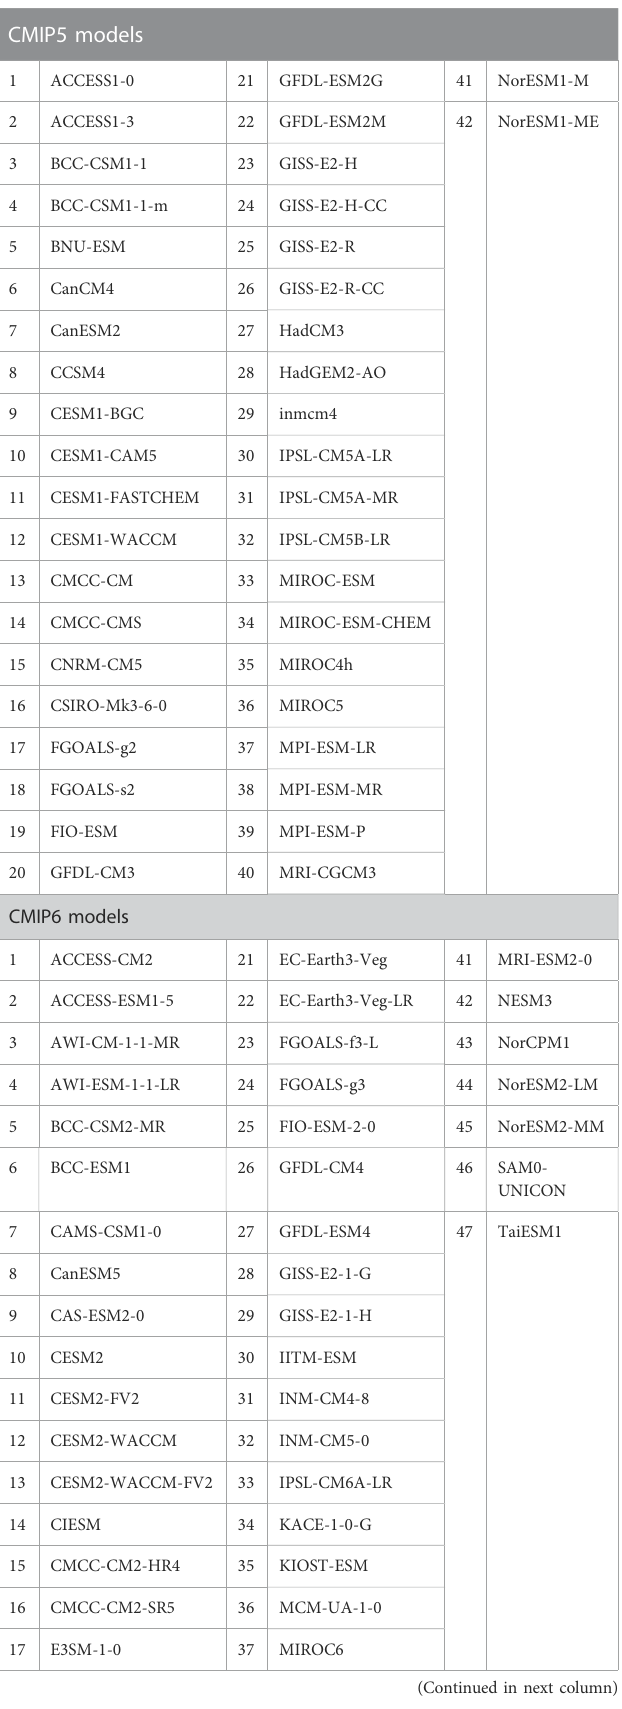
TABLE 1 List of CMIP5/6 models used in this